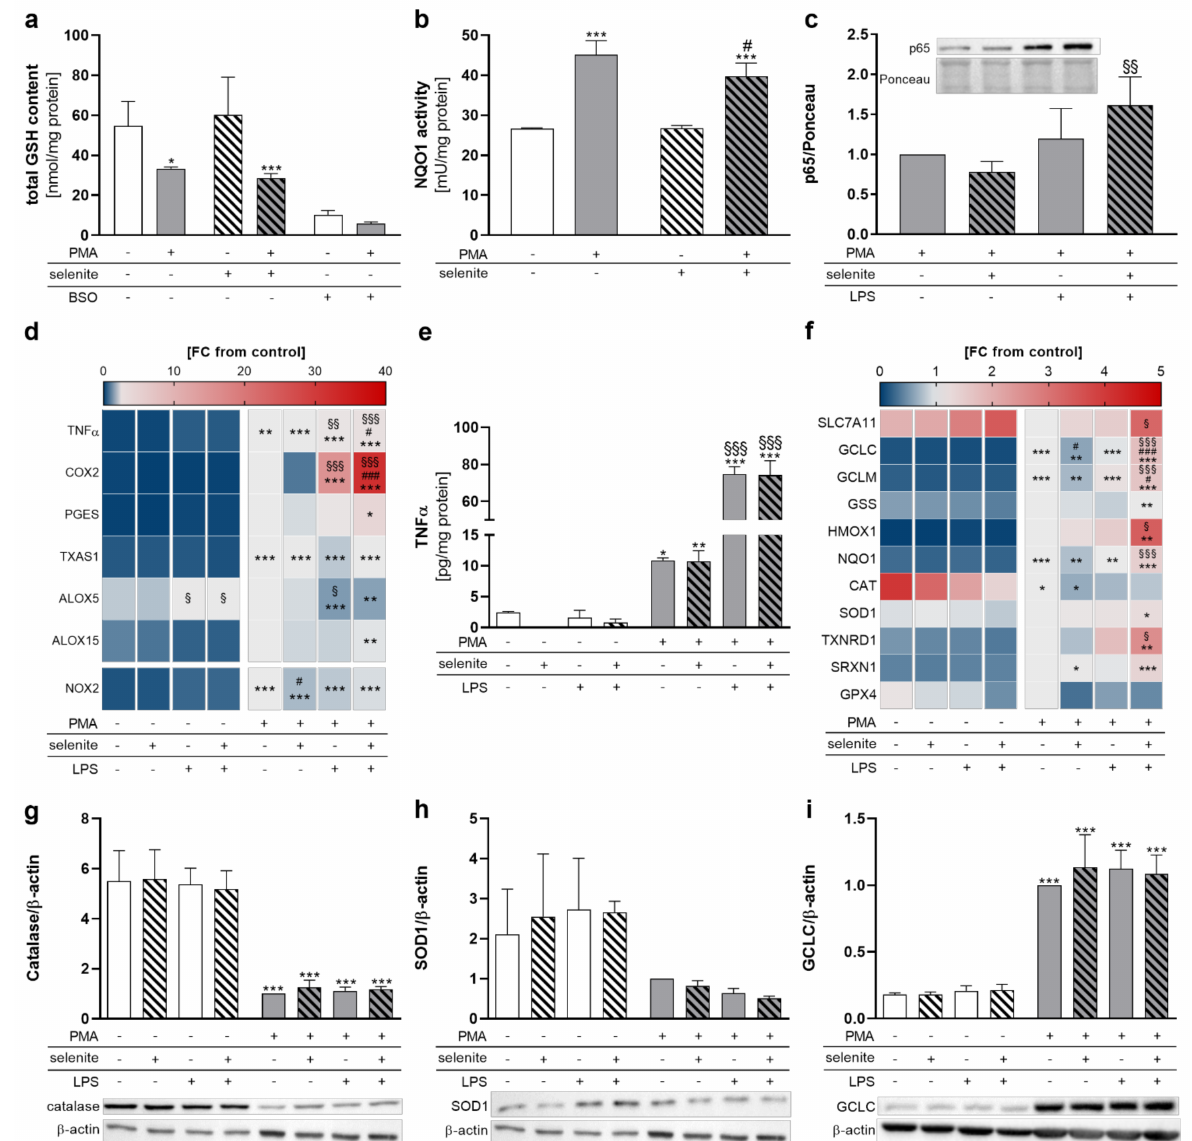
Figure 3. Redox-dependent regulation of NF- κ B and NRF2 target gene transcription in THP-1 monocytes and macrophages. THP-1 monocytes were pre-treated with or without 50 nM sodium selenite (selenite) for 72 h and differentiated into macrophages with 25 nM PMA with or without 50 nM selenite treatment for 48 h. Cells were stimulated with 1 µ g/mL lipopolysaccharide (LPS) ( c – i ) for 1 h ( c ), 6 h ( d , f ), or 24 h ( e , g – i ). ( a ) Total GSH content. The GSH synthesis inhibitor buthionine-sulfoximine (0.25 mM, BSO) was used as positive control. ( b ) NQO1 activity. ( c ) The protein expression of nuclear p65 was normalized to Ponceau staining. The -selenite/-LPS sample was set to 1. ( d ) Heatmap of mRNA expression of NF- κ B target genes and enzymes involved in the LM biosynthesis investigated by qRT-PCR. mRNA expression of genes is given as fold change (FC) vs. +PMA/-selenite/-LPS (FC = 1). The color scale indicates the mean difference as the FC of target genes vs. +PMA/-selenite/-LPS (FC = 1). ( e ) TNF α release was analyzed by ELISA. ( f ) Heatmap of mRNA expression of NRF2 target genes investigated by qRT-PCR. mRNA expression of genes is given as fold change (FC) vs. +PMA/-selenite/- LPS (FC = 1). The color scale indicates the mean difference as the FC of target genes vs. +PMA/-selenite/-LPS (FC = 1). ( g – i ) The protein expressions of CAT ( g ), SOD1 ( h ), and GCLC ( i ) were normalized to β -actin. The +PMA/-selenite/-LPS samples were set to 1. The data of ( a – c , e , g – i ) are given as means + SD (n = 3–4). Two-way ANOVA ( a – c ) or three-way ANOVA ( d – i ) with Bonferroni ´ s post-test. Significant outliers were determined by Grubbs ´ test ( α = 0.05). * p < 0.05, ** p < 0.01, *** p < 0.001 vs. cells without PMA (PMA effect); # p < 0.05, ### p < 0.001 vs. cells without selenite (Se